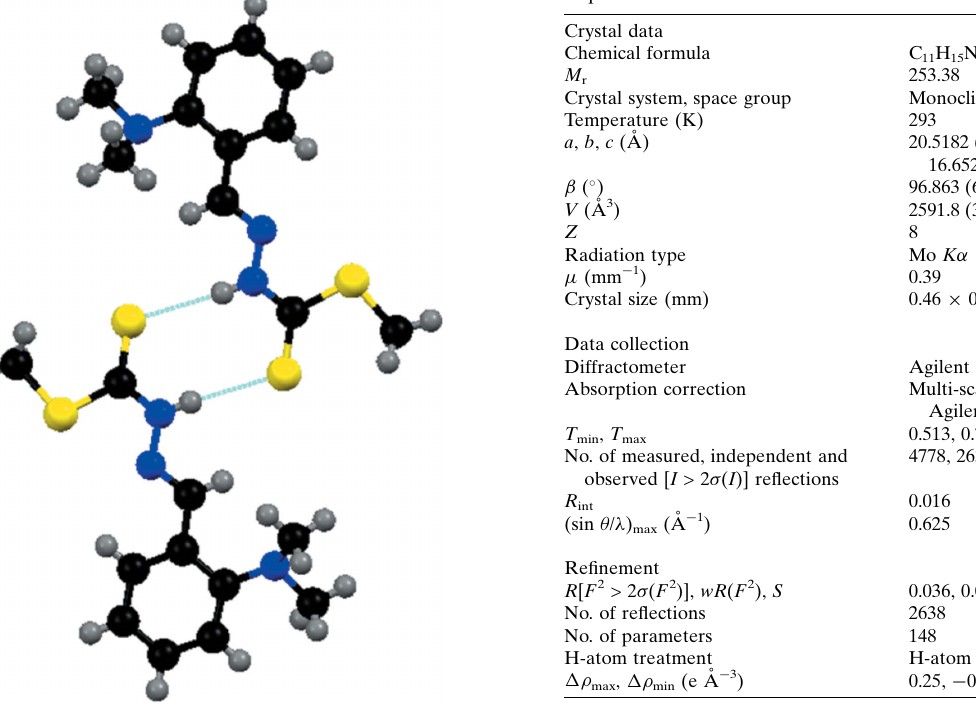
Figure 2 Dimer formation through N—H (cid:3)(cid:3)(cid:3) S interactions.